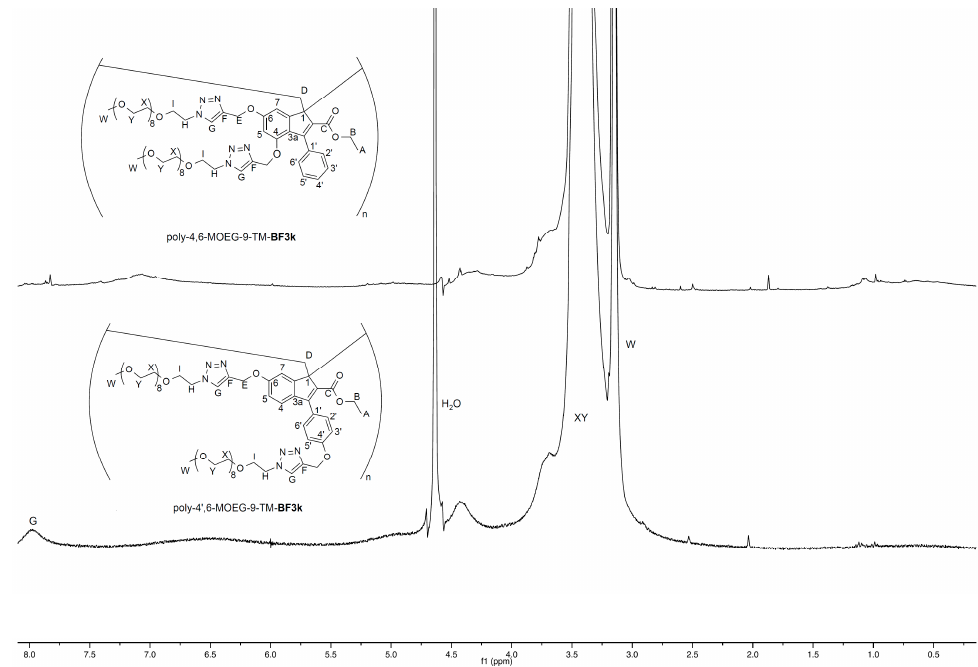
Figure 13. Comparison between the 1 H NMR spectra of poly-4,6-MOEG-9-TM- BF3k (D 2 O, with water suppression) and poly-4’,6-MOEG-9-TM- BF3k (D 2 O).